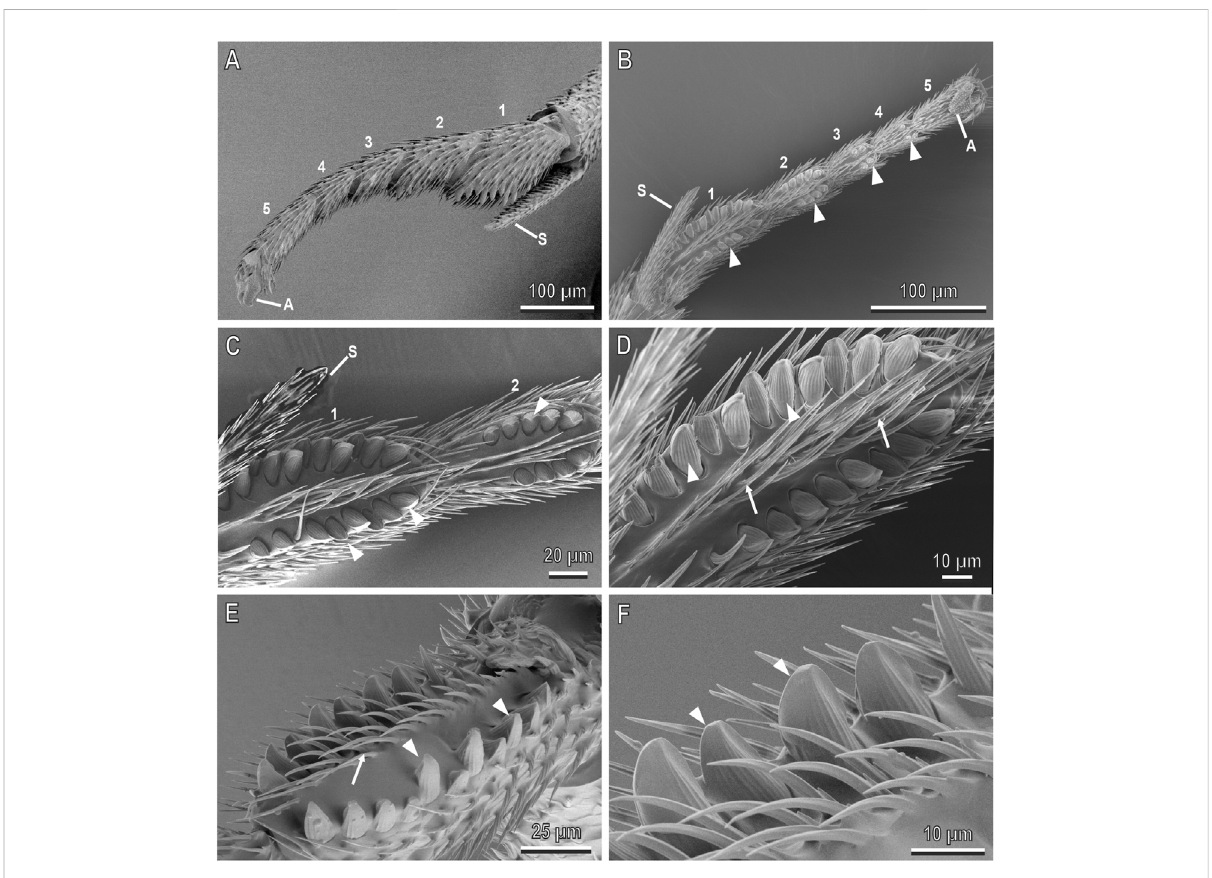
FIGURE 4 Midleg tarsi of the female of A. bifasciatus in cryo-SEM . (A) , Lateral view of the tarsus showing fi ve curved tarsomeres (1 – 5) with the fi rst tarsomere wider than the others; (B) , Ventral view of the tarsus showing the two lateral rows of big and thick pegs (arrowheads); (C,D) , Detail of (B) showing the fi rst and second tarsomeres with the two rows of articulated pegs (arrowheads) surrounding a row of setae (arrows); (E,F) , Details showing the pegs (arrowheads) slightly curved towards the inner portion of the tarsomere, with longitudinal grooves. Pegs are surrounded by setae (arrows). A, arolium; S, tibial